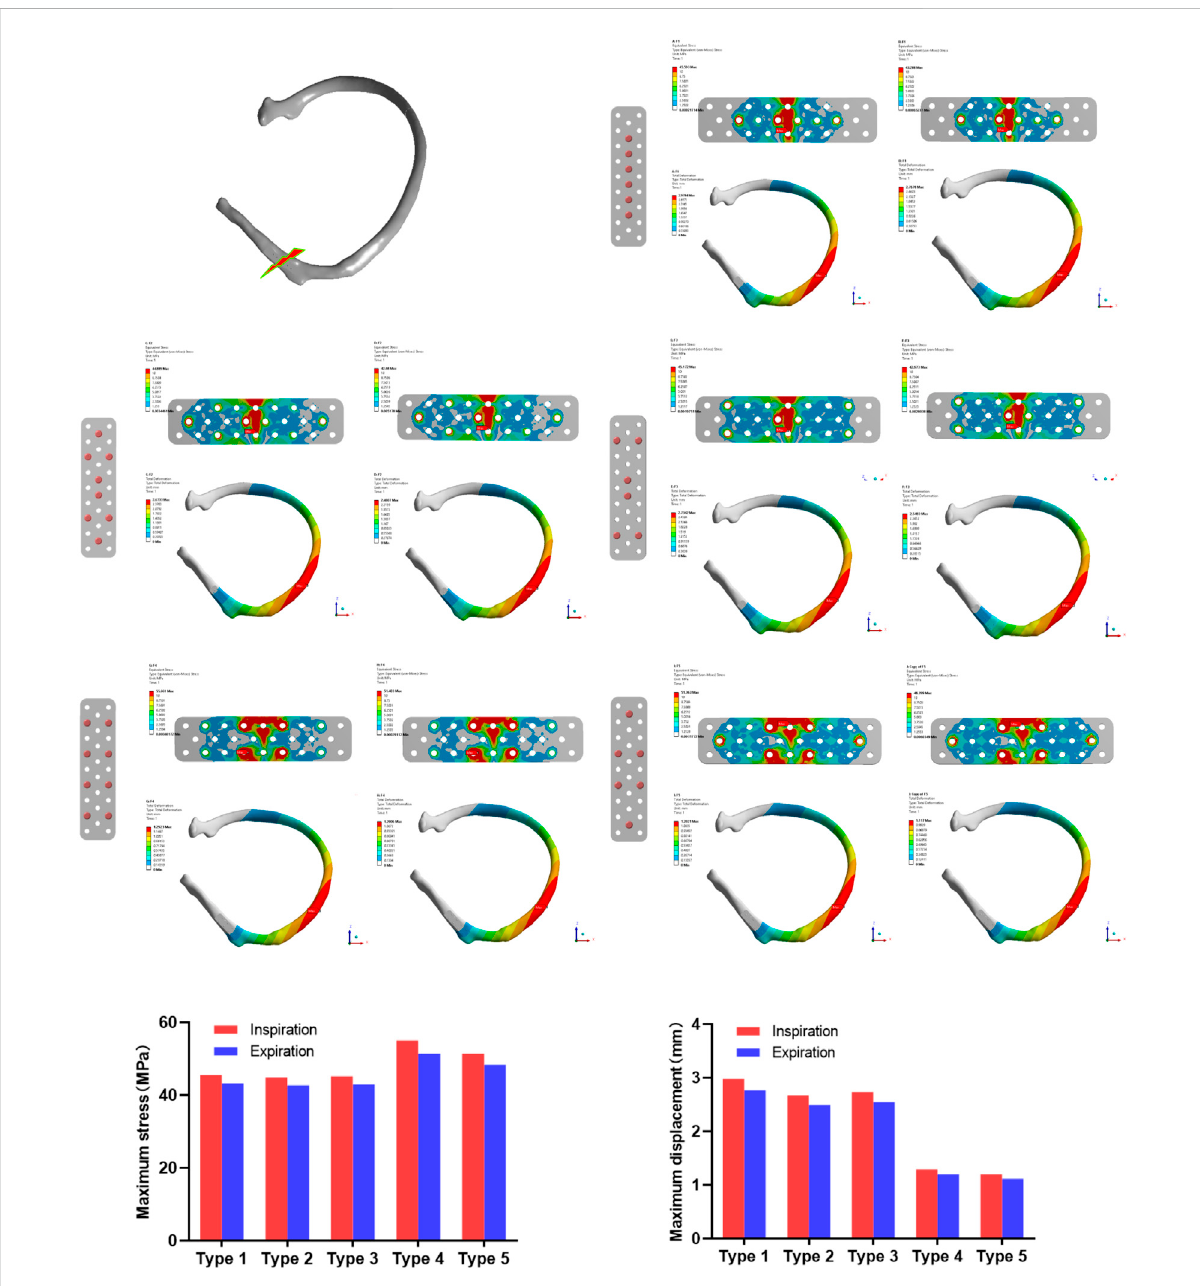
FIGURE 3 Themaximumstressand displacement duringinhalationand exhalation withanterior ribfracture in5differentscrewmodes after plate fi